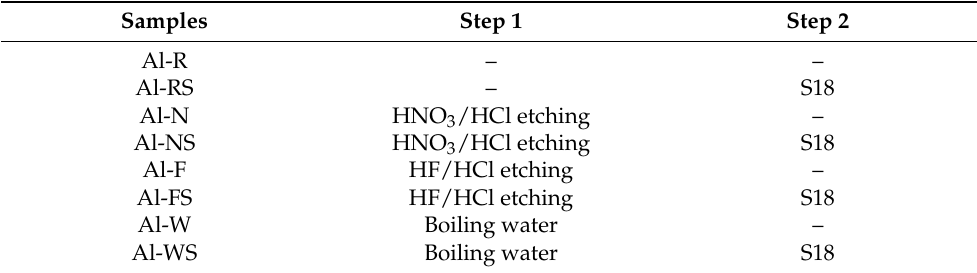
Table 1. Sample codes and